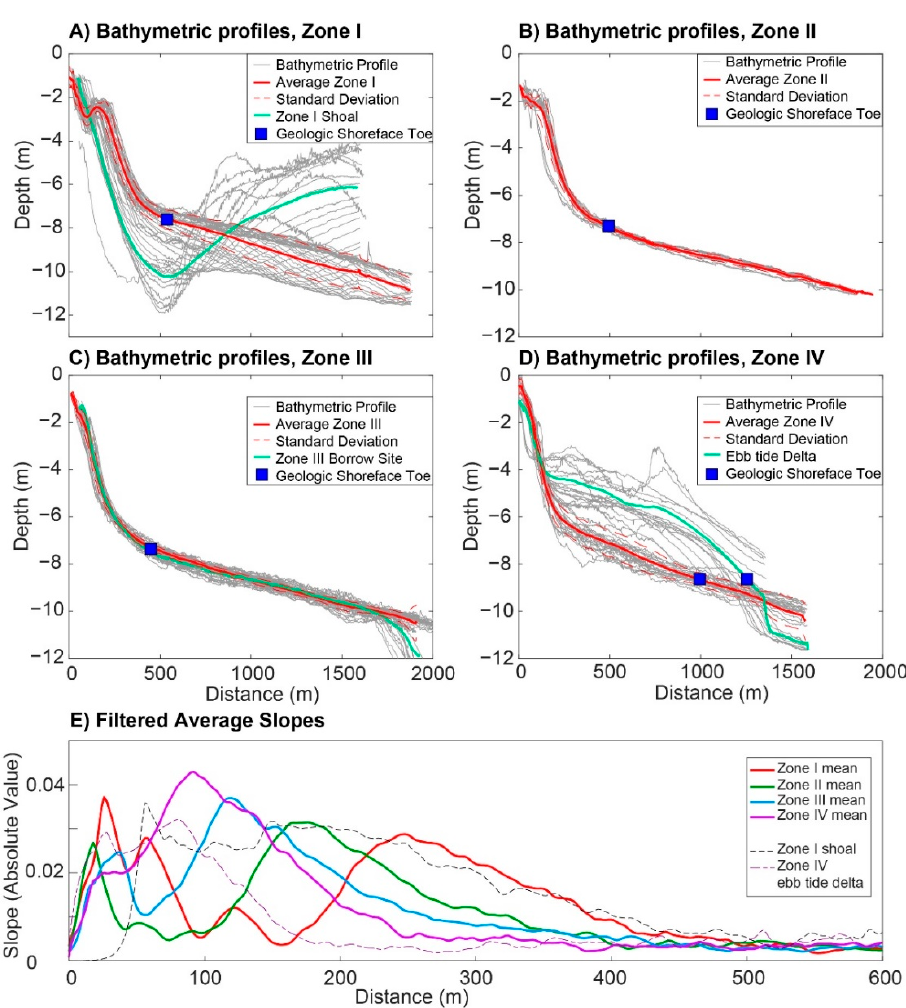
Figure 6. ( A – D ) Bathymetric profiles through the shoreface are shown for each geomorphic zone. Individual profiles are represented as gray lines; red lines represent the average; and green lines in ( A , C , D ) represent average bathymetry of geomorphic features. Blue squares on the profiles represent the average depth of the geologic shoreface toe (GST). ( E ) Slopes of each profile were averaged for zones I–IV, the zone I shoal, and the zone IV ebb tide delta. Filtered absolute values of average slope are shown.